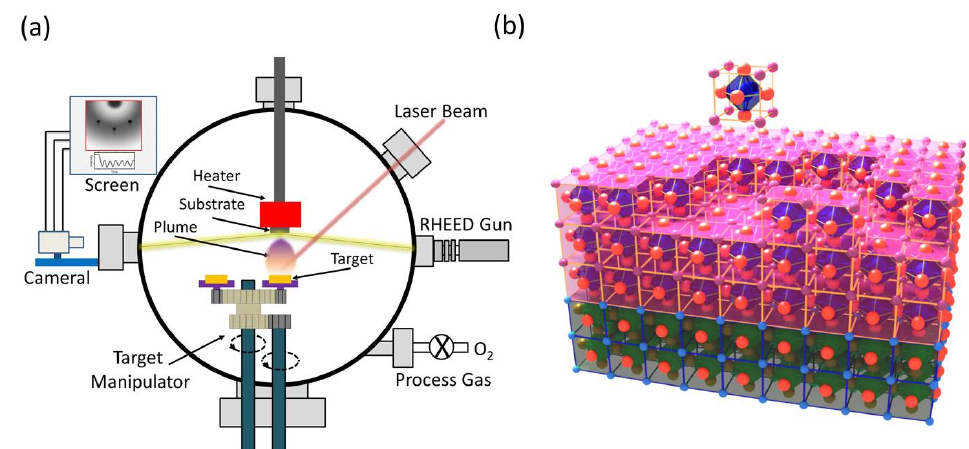
Figure 2. ( a ) Schematic drawing of a pulsed laser deposition setup. ( b ) Unit cell control of the synthesis of a specific ABO 3 perovskite film (top layer) on a A′B′O 3 pervoskite substrate (bottom layer).